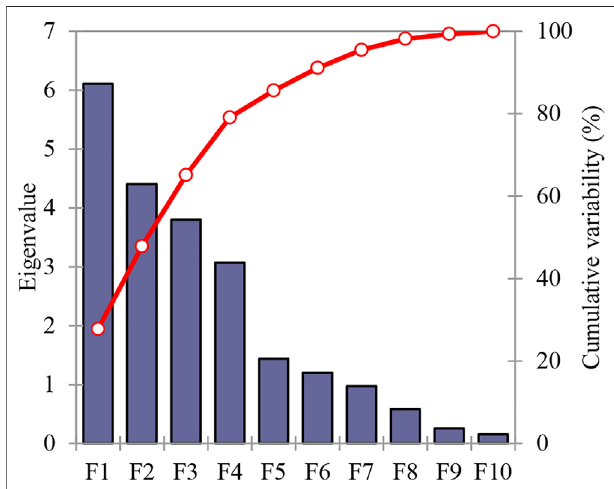
FIGURE 2 | Eigenvalues and cumulative variance of principal components.